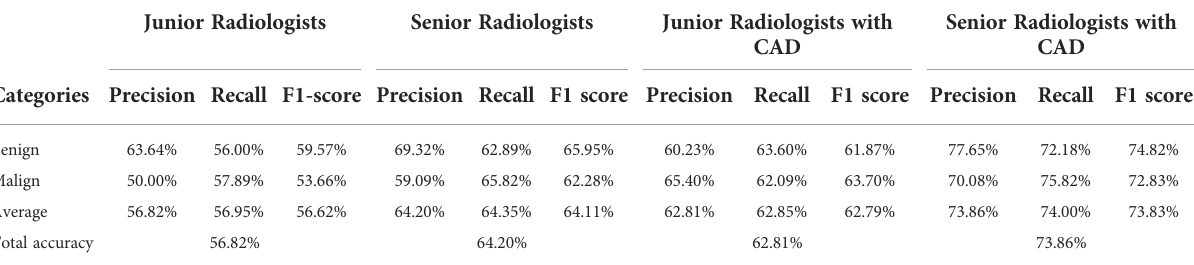
TABLE 5 Evaluation results of radiologists on the balanced set.